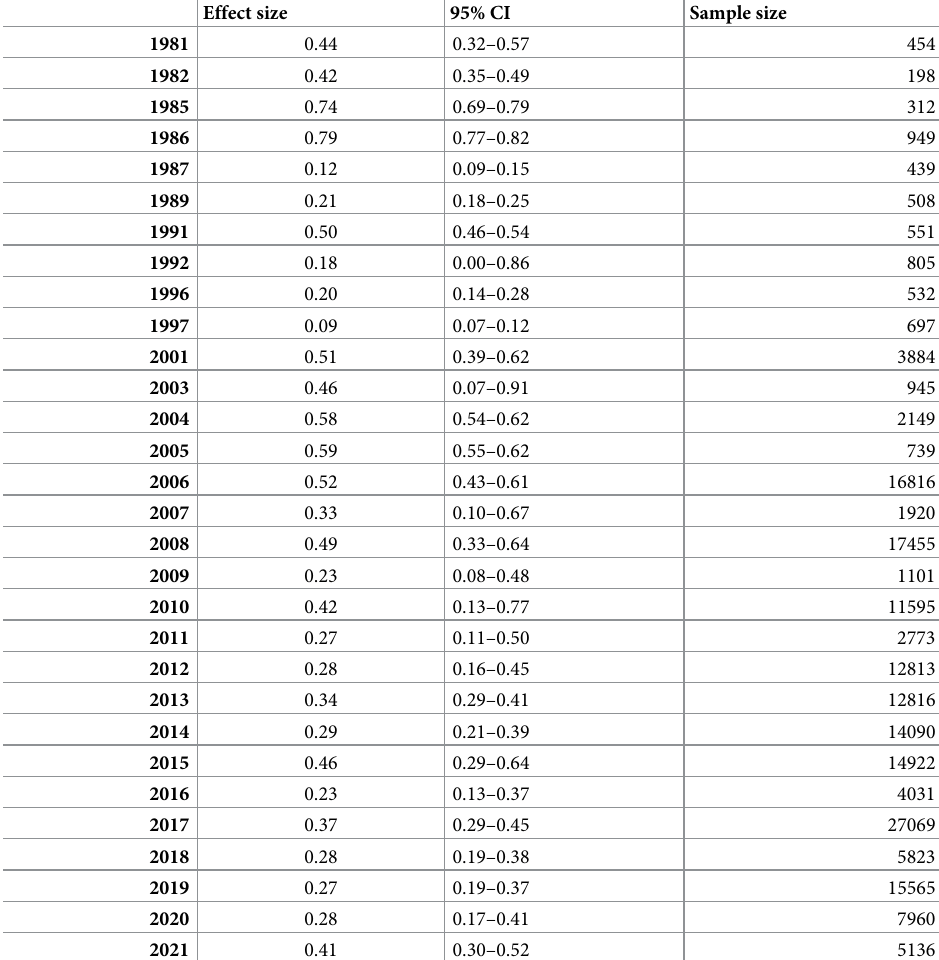
Table 1. Effect sizes of prevalence of unemployment by